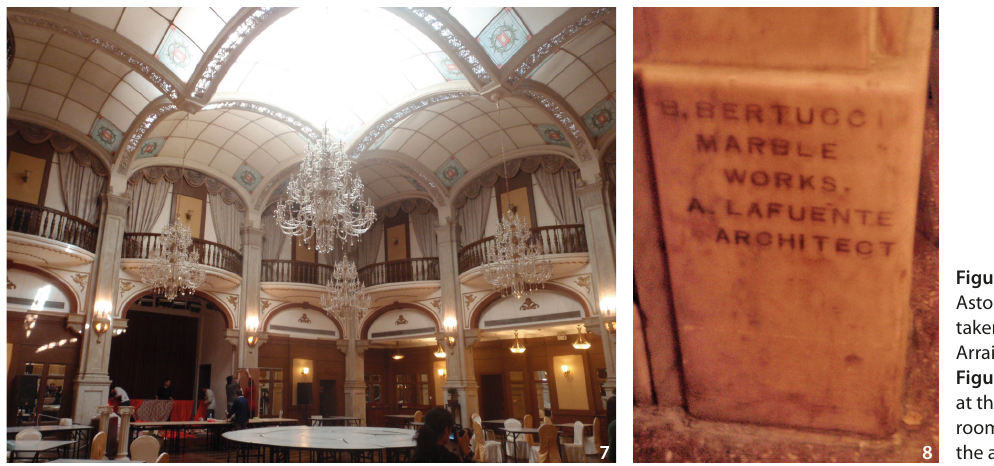
Figure 7 A photograph of the Astor House Hotel ballroom, taken in 2011 (Source: Noel Arraiz). Figure 8 Column lower detail at the Astor House Hotel ball- room taken in 2011 (Source: the author).